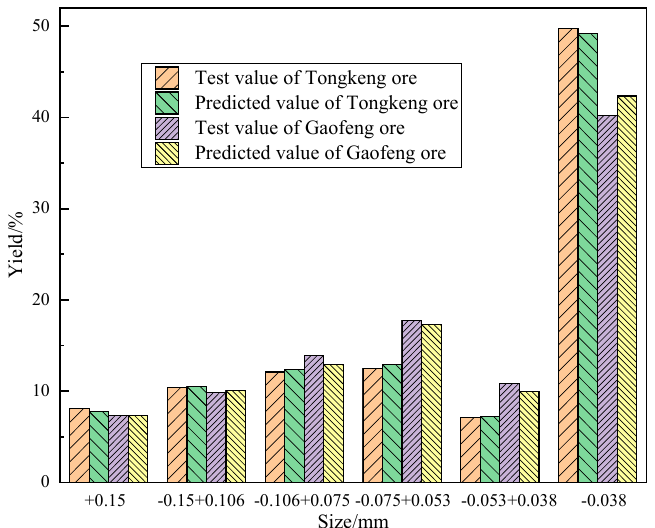
Figure 9. Prediction results of JK drop-weight method for Tongkeng ore and Gaofeng ore. Table 9. Error comparison of Tongkeng ore and Gaofeng ore.